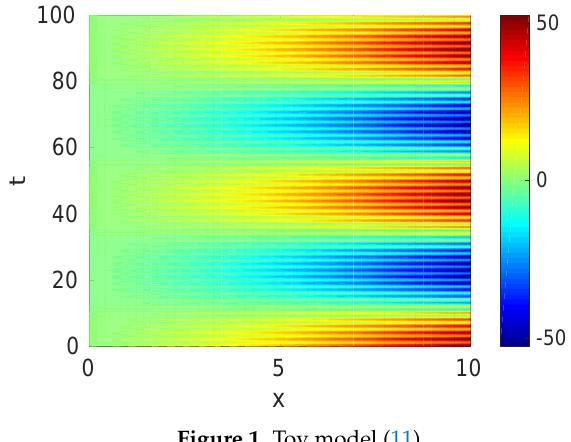
Figure 1. Toy model